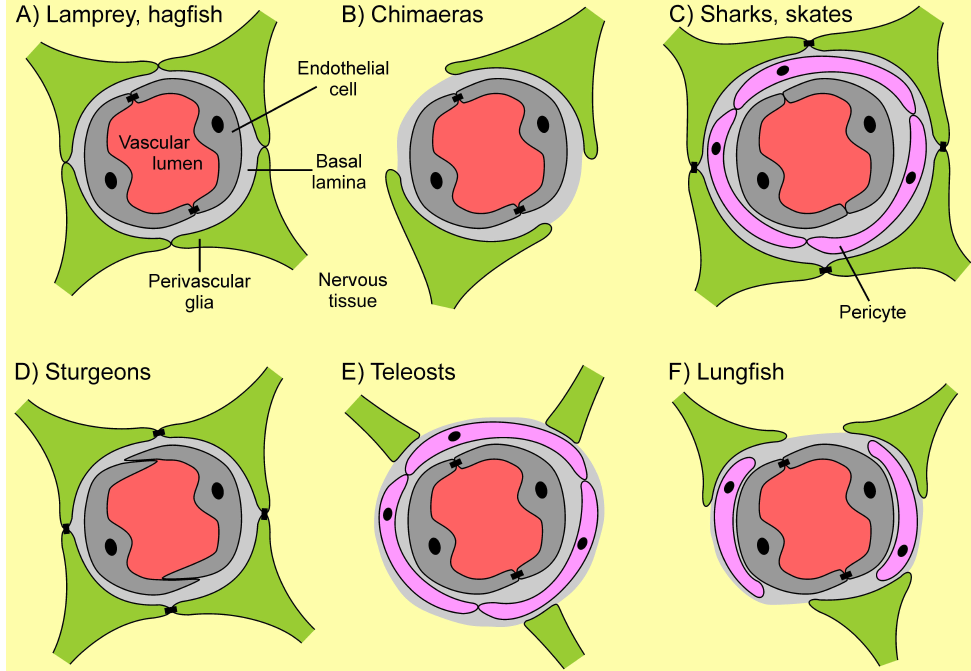
Figure 3. Schematic representation of the blood-brain barrier in fish. Cross section of a fish neurovas- cular unit; black bars indicate the site of the BBB. ( A ): NVU of lamprey and hagfish. Hagfish/lamprey have an endothelial barrier with tight junctions between endothelial cells. Glial cells form a con- tinuous layer around endothelial cells. Basal lamina is present; no pericytes are present. ( B ): NVU of chimaeras. Chimaeras have an endothelial barrier, basal lamina, and a discontinuous glial layer. Pericytes are not present. ( C ): NVU of elasmobranchs—sharks and skates. Glial cells form the BBB and are joined by tight junction proteins. Endothelial cells are not joined by tight junctions and form a leaky layer. Pericytes are present between glial cells and endothelial cells. Basal lamina is present. ( D ): NVU of sturgeons. Sturgeons have a glial BBB, but glial cells are not joined by tight junctions. Endothelial cells are joined by tight junctions but form a leaky layer. Pericytes are not present; basal lamina is present. ( E ): NVU of teleosts. Teleosts have an endothelial BBB, and endothelial cells are joined by tight junctions. Glial cells are radial glia and are discontinuous. Pericytes are present and are between endothelial cells and glial cells. Basal lamina is present. ( F ): NVU of lungfish. Lungfish have an endothelial BBB, and endothelial cells are joined by tight junctions. Glial cells are present and are discontinuous. Perivascular cells are present, but it is unclear whether these cells are pericytes. Basal lamina is